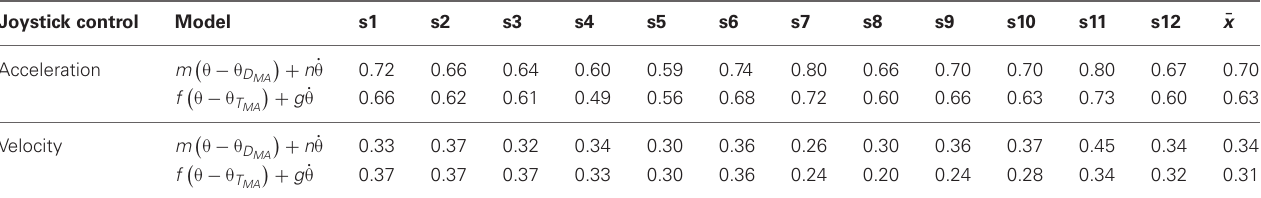
Table 5 | Proportion of variance explained ( R 2 ) by each model for individual response data in the velocity-control and acceleration-control